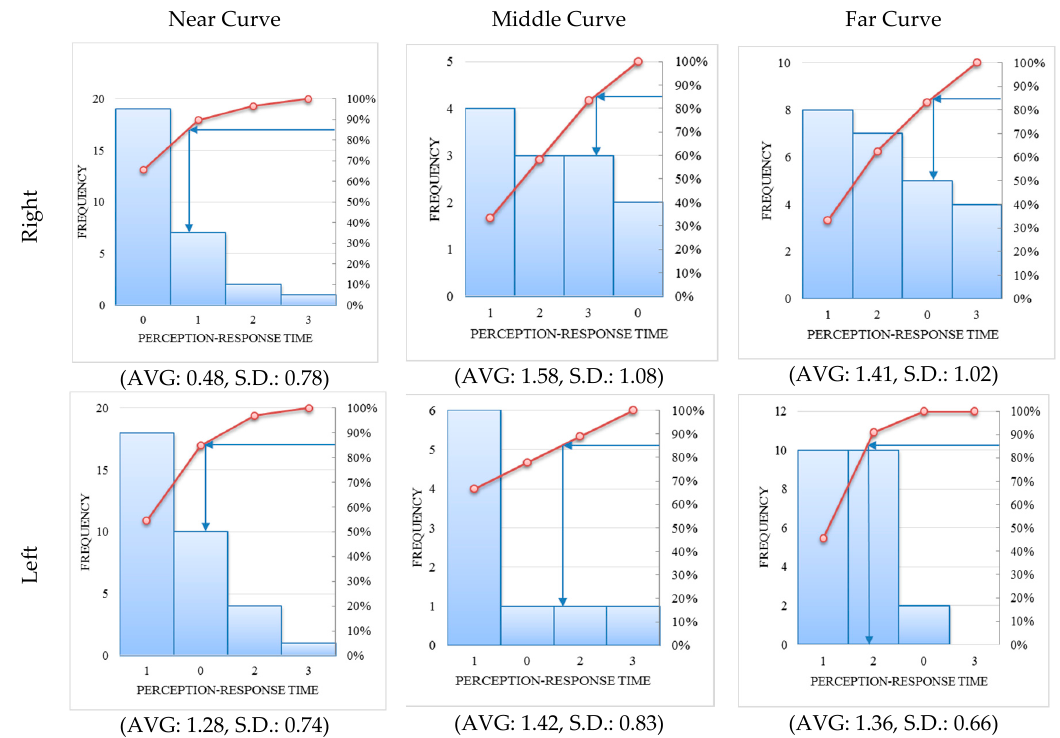
Figure 4. Histogram and cumulative frequency curve of perception-response time on six types of curves. Table 3. Average Value of Three Mechanical Coefficients of Variation (CV) on Six Types of Curves.